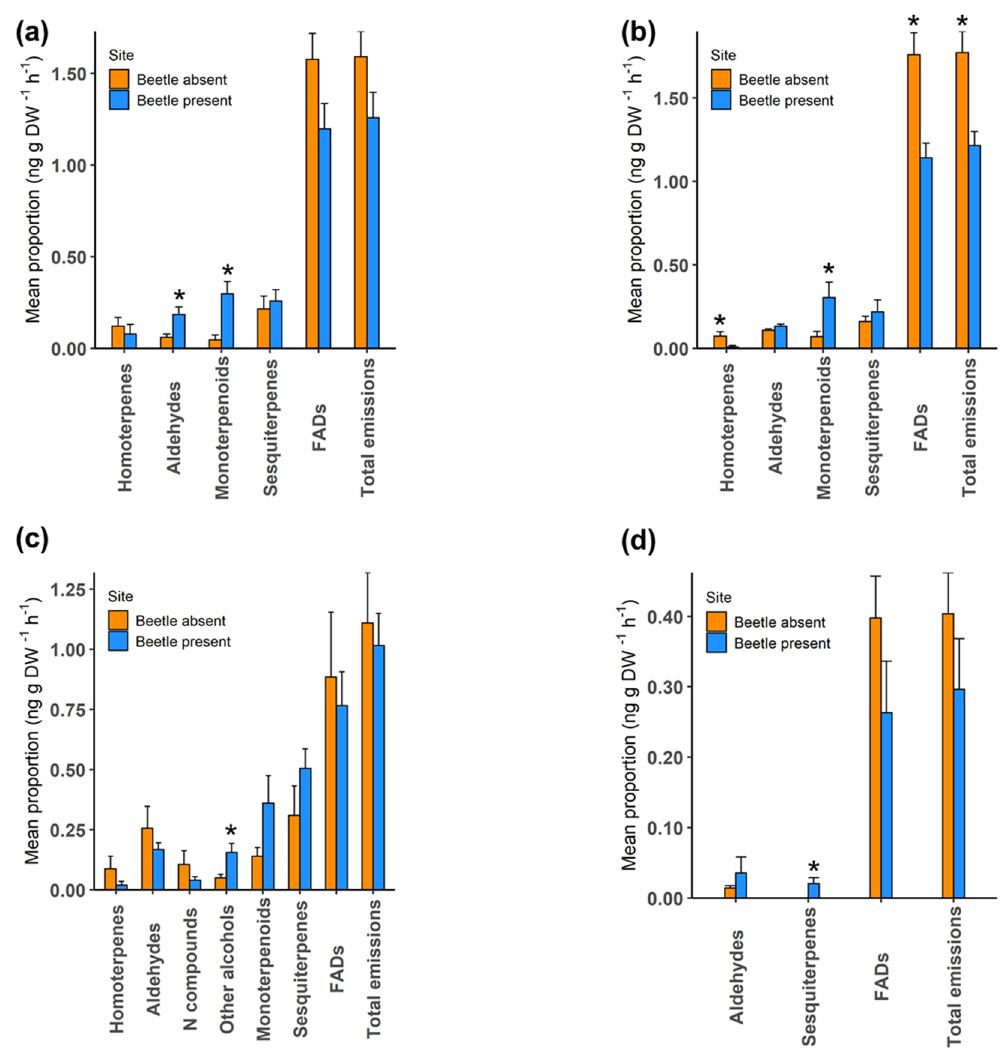
Figure 4. Comparison of major chemical classes between sites at ( a ) 14 November 2018, ( b ) 11 December 2018, ( c ) 31 January 2019 and ( d ) 25 March 2019. Y-axis shows log10x + 1 transformed mean ± SE proportion of chemical classes and asterisk indicate a significant di ff erence. n = 7 for the beetle-present site in ( c ), otherwise 8 replicates per treatment at each sampling time. Asterisk indicates significant di ff erences (* p <